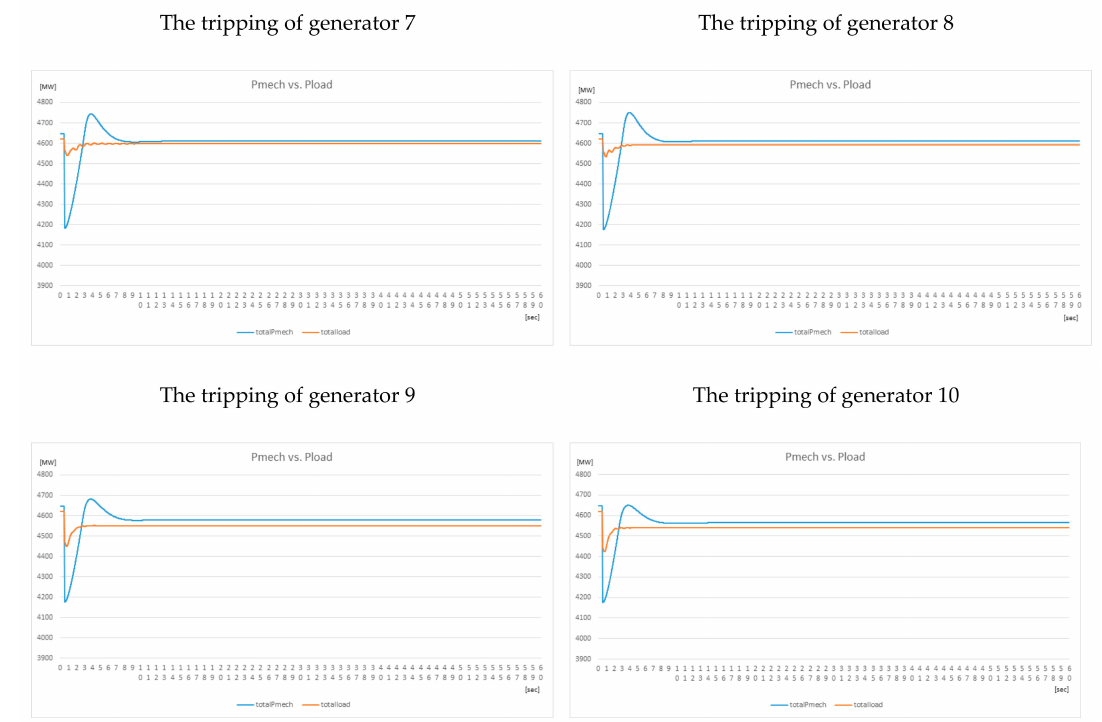
Figure A1. Balance of supply and demand based on the tripping of